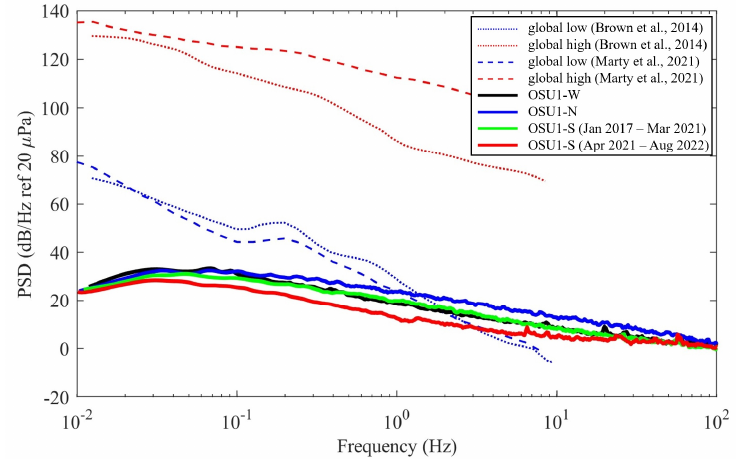
Figure 2. OSU1 microphone noise floors compared with low and high global noise levels [34,35].